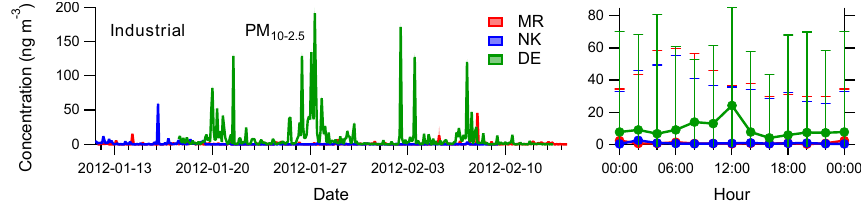
Figure 14. Time series (left) and diurnal variations (right) of the industrial factor at MR, NK and DE for PM 10–2 . 5 . Time series show the mean of all good solutions ± 1SD as shaded areas. Diurnals show the mean of the time series ± 1SD as whiskers, with the hour being the start of a 2h sampling period (00:00UTC means sampling from 00:00 to 02:00UTC).